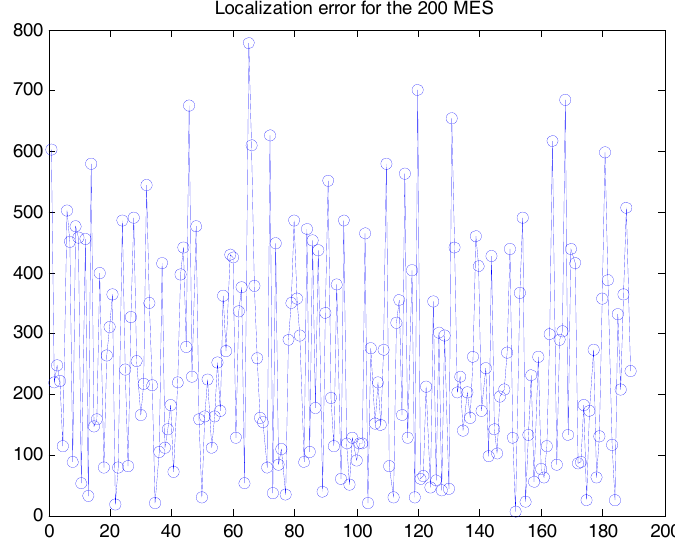
Figure 5. Localization error for the 200 unknown nodes.